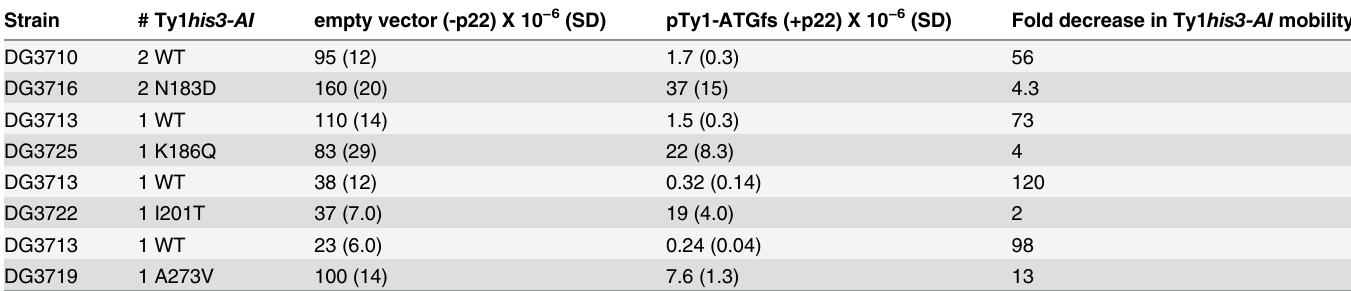
Table 1. Genomic CNC-resistant Ty1 his3-AI